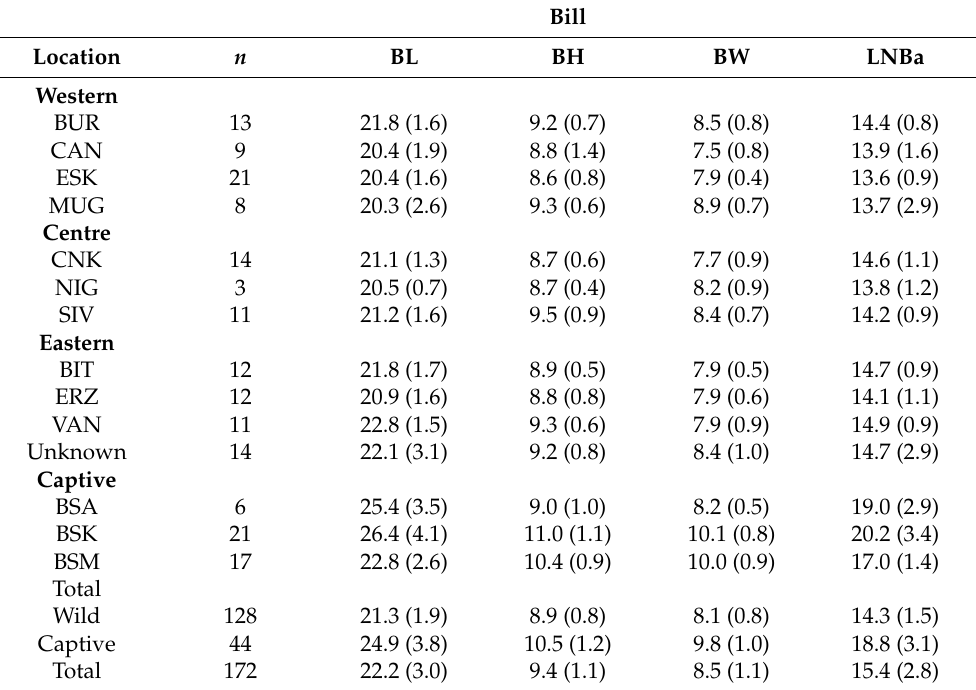
Figure 4. PCA of male (yellow) and female (blue) Chukar Partridges bills. ( a ) Morphometric ( M ; size), ( b ) geometric morphometric ( GM ; shape), and ( c ) M + GM together. Table 2. Basic descriptive statistics of the bill for wild and captive populations. SD is given in parent